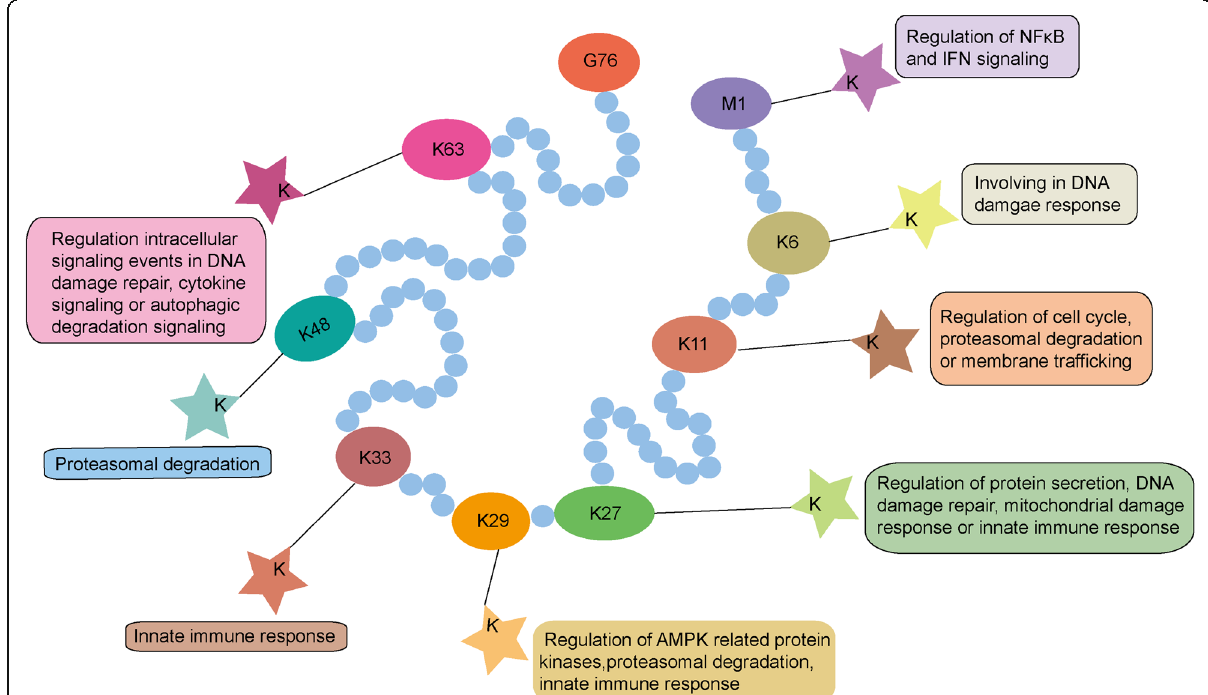
Fig. 1 Different ubiquitin linkage types and their functions. Ubiquitin (Ub) a small protein consists of 76 amino acids highly conserved among all eukaryotes. Ubiquitin is characterized by its 7 lysine sites (K6, K11, K27, K29, K33, K48, K63) and N-terminal methionine1 (Met1) site, which are also functional sites. Due to these specific linkage sites, ubiquitination can be classified into different styles and then perform distinct biological functions. And ubiquitin attaches to target substrate through identifying its lysine (K)